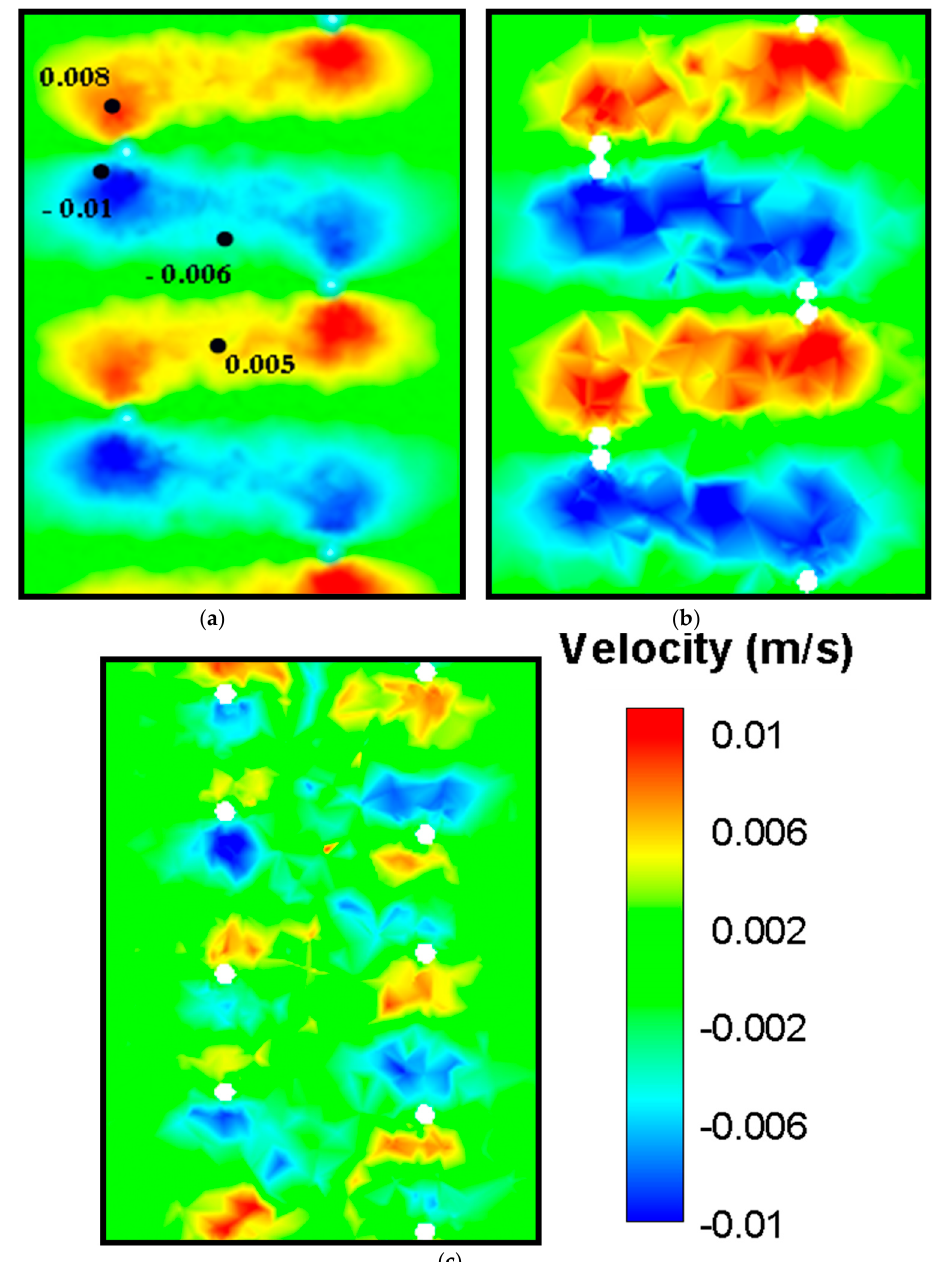
Figure 6. CFD simulations for radial velocity V x plotted in the center-plane, increases from single flagellum ( a ) to in-phase double flagella configuration ( b ) and decreases for the out-of-phase double flagella configuration ( c ).